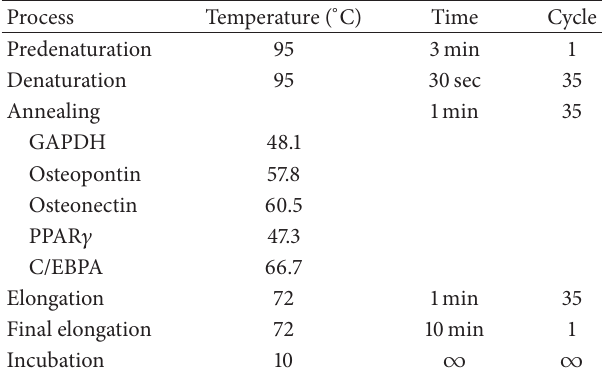
Table 3: PCR gene amplification conditions for GAPDH, osteo- pontin, osteonectin, PPAR 𝛾 , and C/EBPA gene for adipogenesis and osteogenesis differentiation